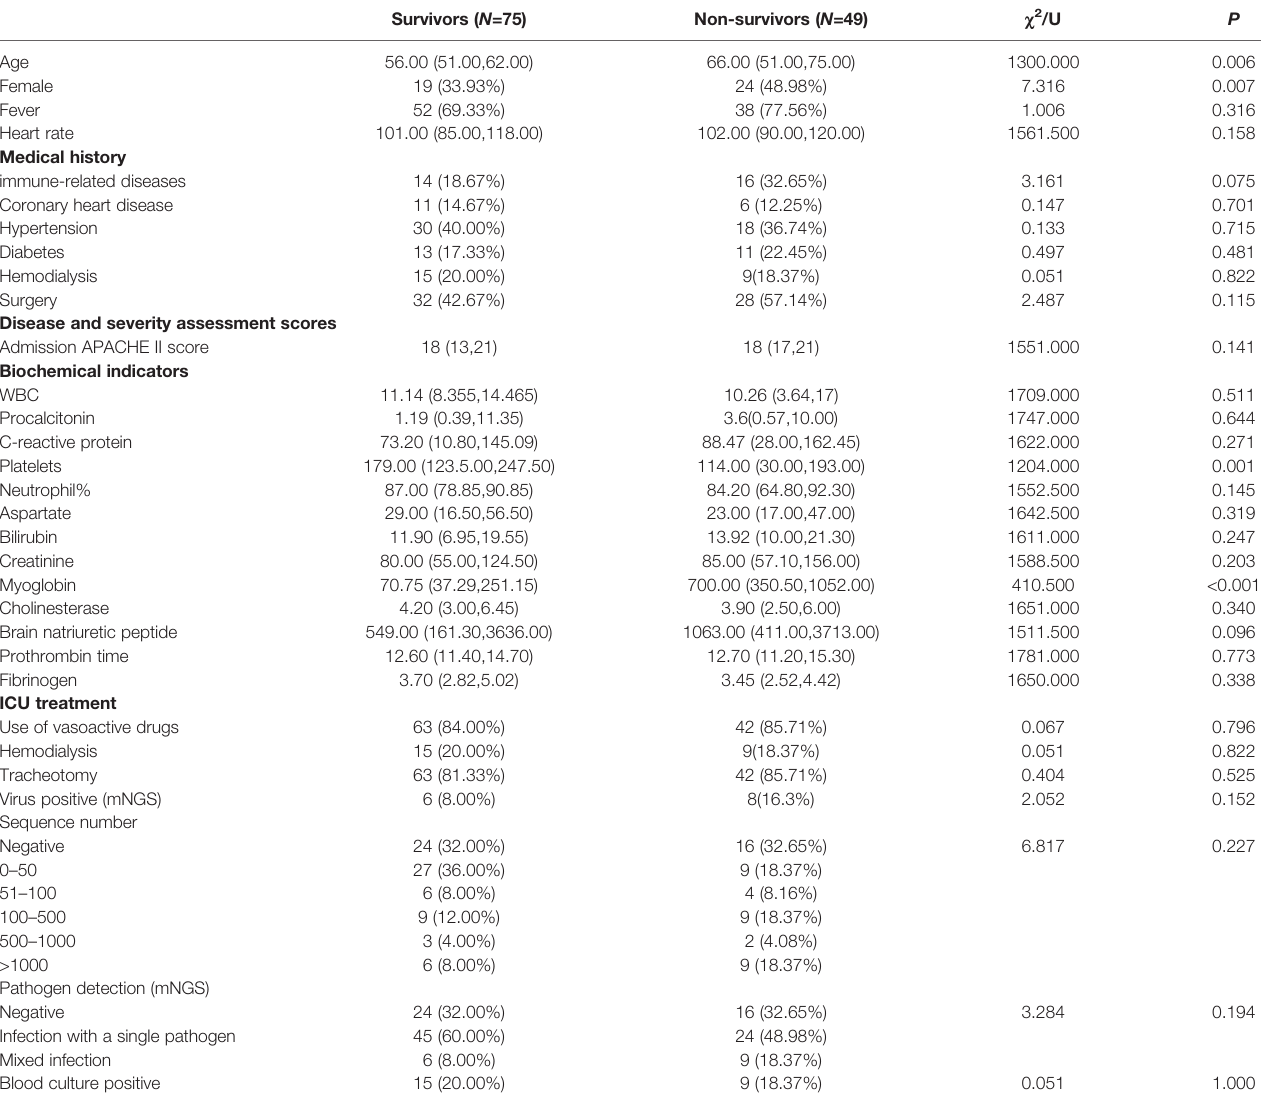
TABLE 5 | Analysis of factors affecting the prognosis of sepsis